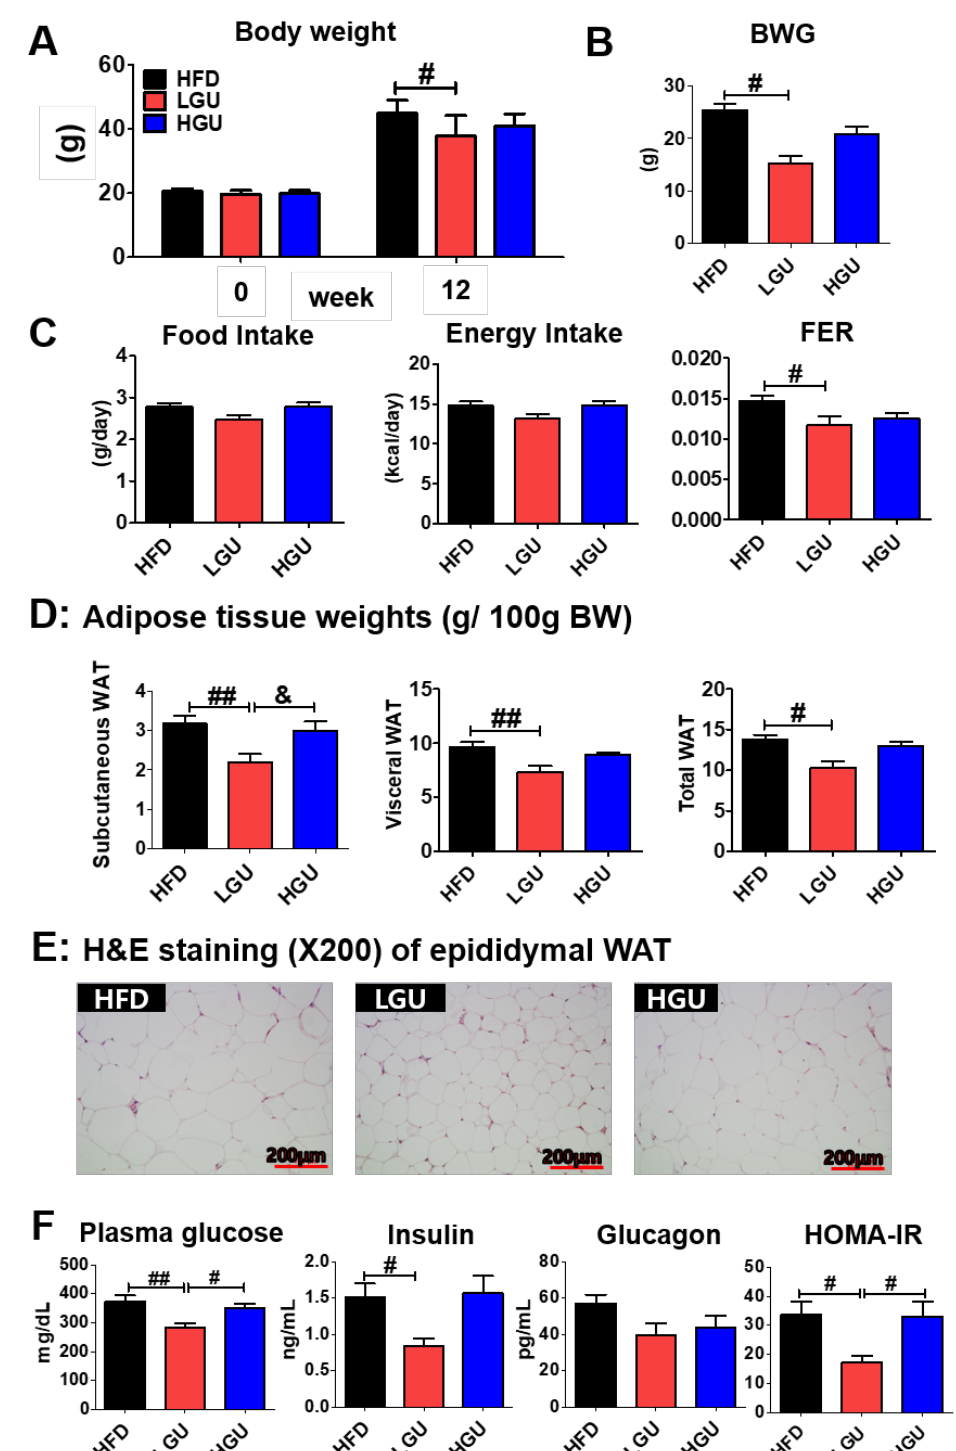
Figure 1. Effects of low-dose G. uralensis Fischer extract supplementation on diet-induced obesity with respect to body weight ( A ); body weight gain ( B ); food intake, energy intake, and food efficiency ratio ( C ); adipose tissue weight ( D ); epididymal white adipose tissue morphology (200 × magnification) ( E ); and levels of plasma glucose, insulin, glucagon, and HOMA-IR ( F ). Data are presented as the mean ± SEM. Significant differences among the high-fat diet groups are indicated: # p < 0.05, ## p < 0.01. Significant differences between LGU and HGU are indicated: & p < 0.05. HFD, high-fat diet (60 kcal% fat); LGU, HFD + 0.015% G. uralensis Fischer; HGU, HFD + 0.03% G. uralensis Fischer.